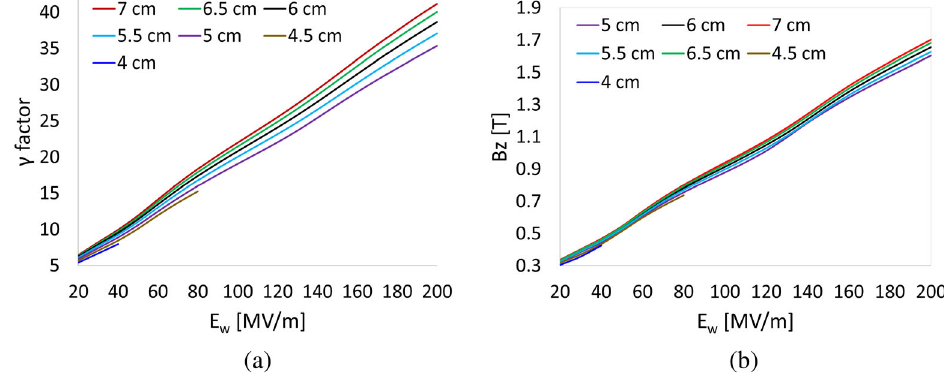
FIG. 5. (a) Final maximum gamma factors vs E